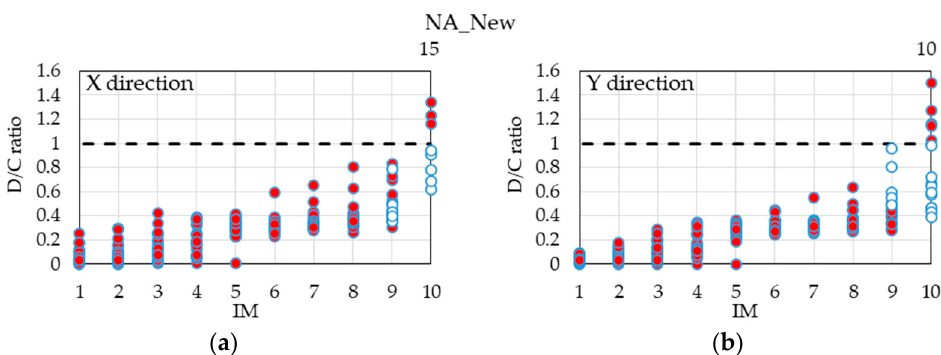
Figure 14. Displacement D/C ratios of the superstructure (UPD): NA_New X ( a ) and Y ( b ) directions.